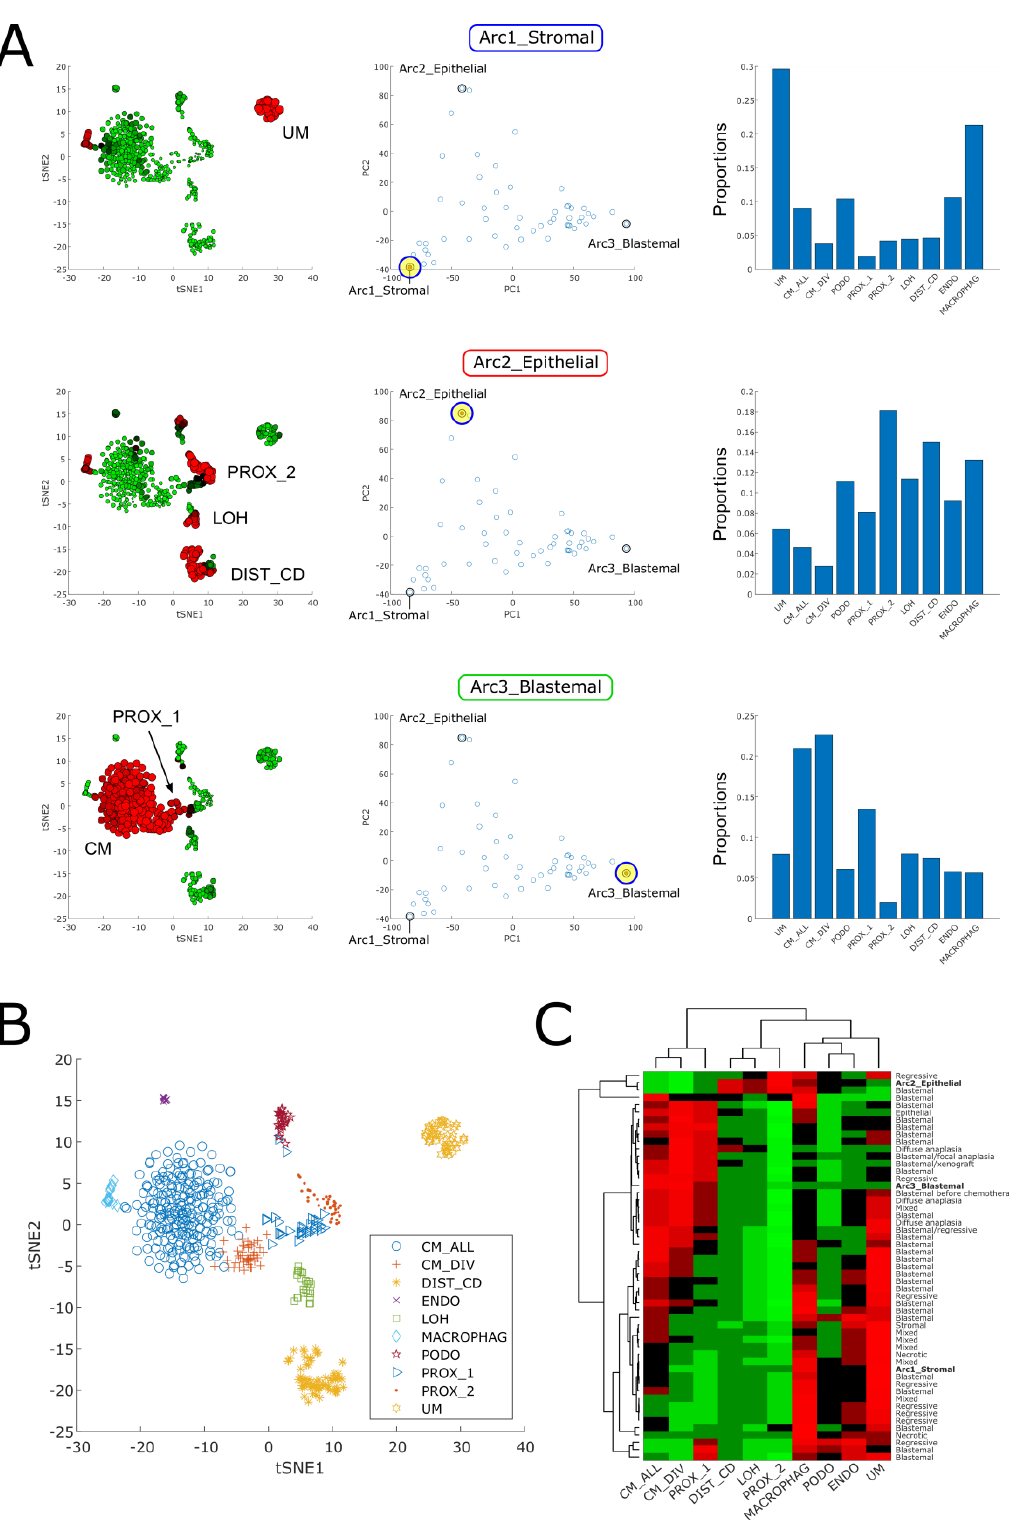
Figure 4. Cellular deconvolution indicates that each tumor is composed of a unique mixture of cell populations resembling those of the fetal kidney. ( A ) Shown is a cellular deconvolution of the stromal, blastemal, and epithelial archetypes. The left panels show tSNE plots of the reference single cell RNAseq dataset from the developing mouse fetal kidney that was used for the deconvolu- tion. The size and color of each point (=single cell) corresponds to the proportion of that cell in the specific de-convolved tumor (red large – high expression, green small – low expression). The middle panels highlight the relevant tumor or archetype in the PCA latent space. The right panels show bar